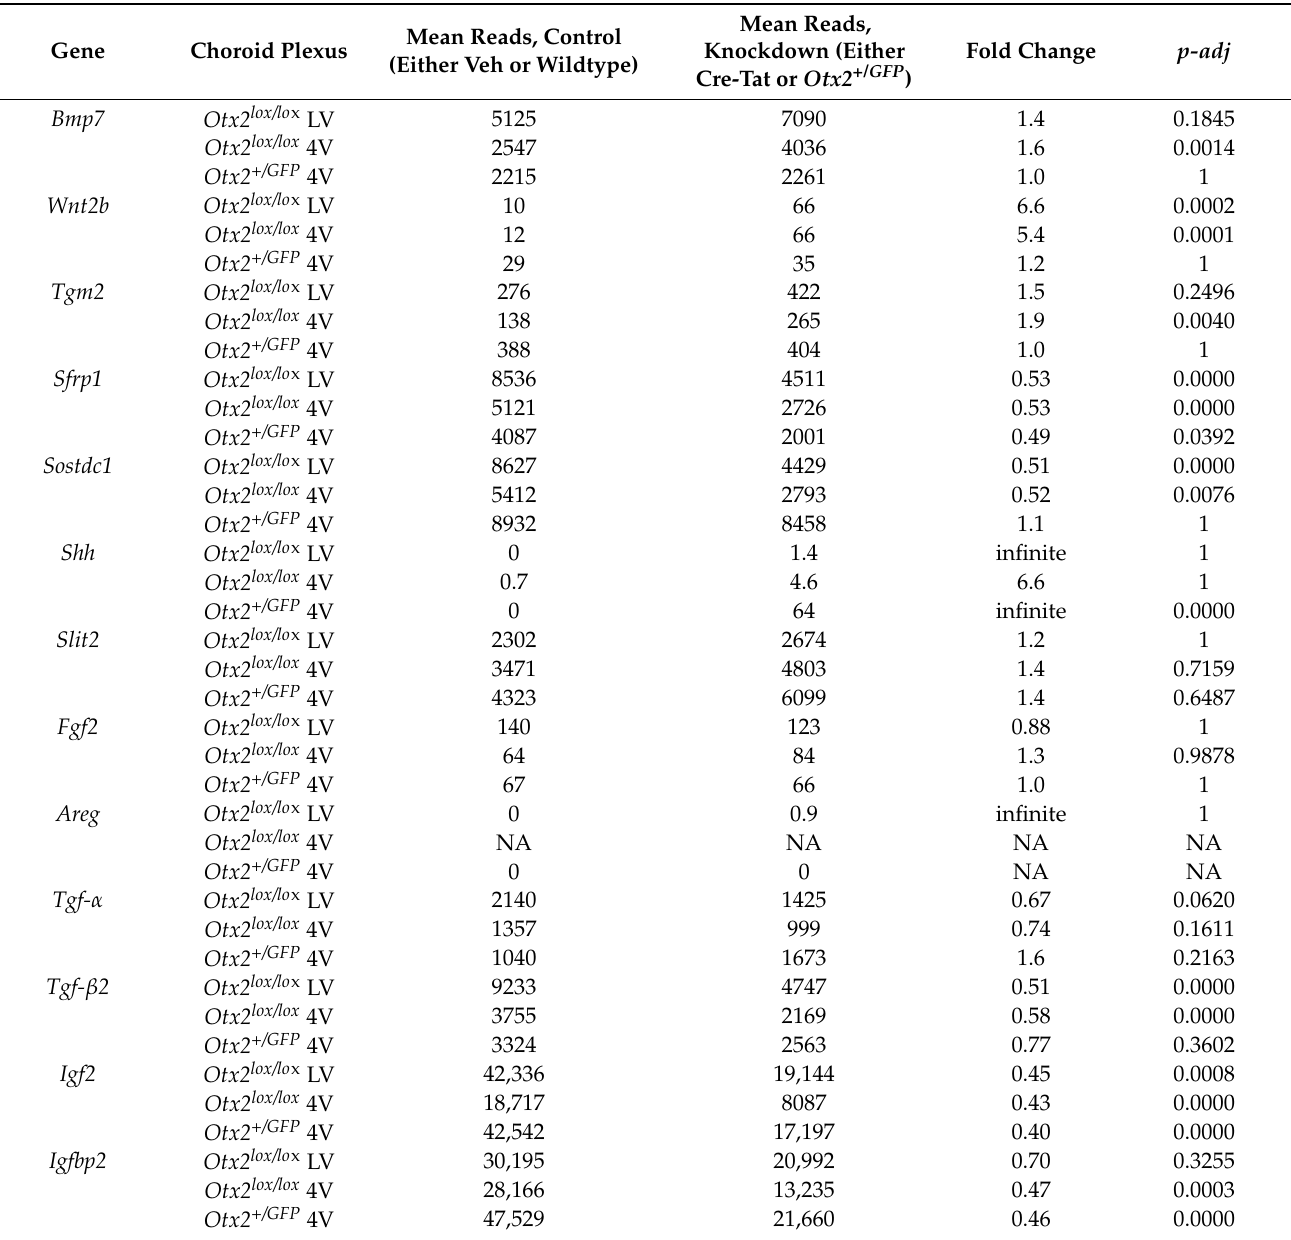
Table 4. Expression of secreted factors in Otx2 knockdown